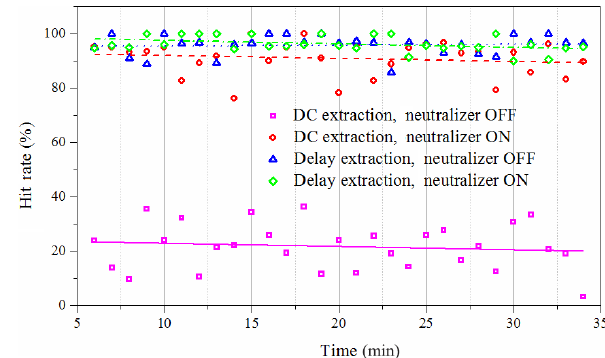
Figure 4. Hit rate count for four cases: DC extraction with no neu- tralizer, DC extraction with the neutralizer on, delayed extraction with no neutralizer, and delayed extraction with the neutralizer